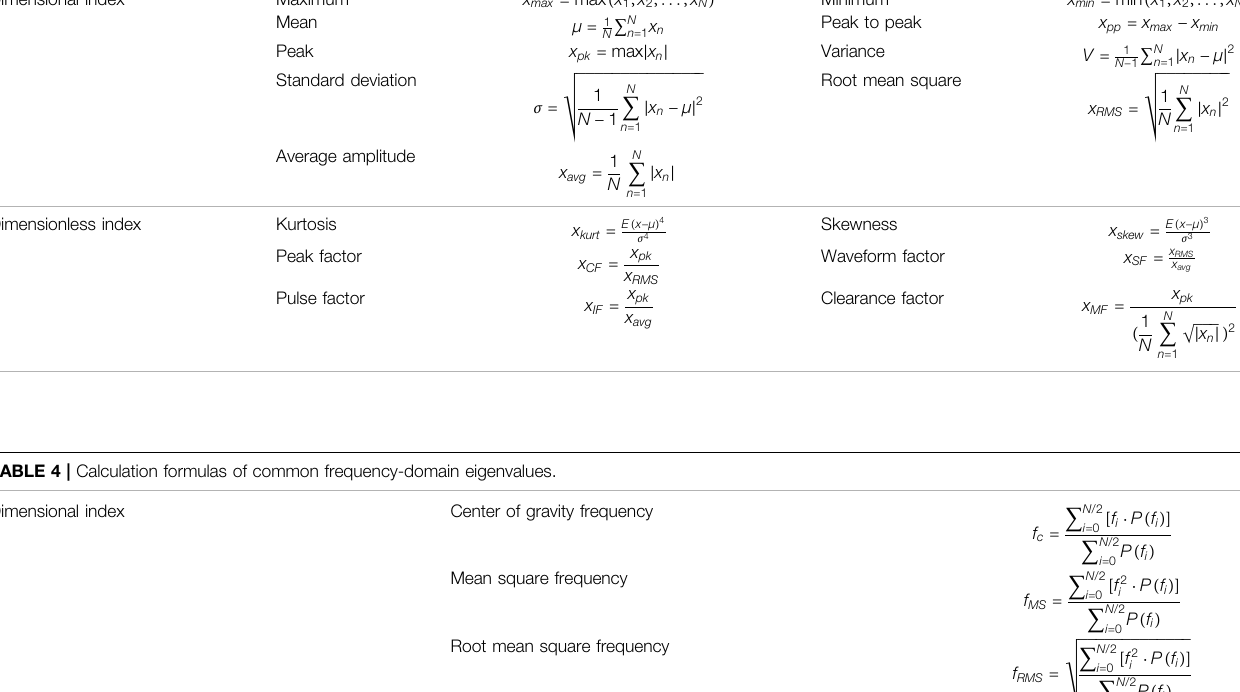
TABLE 3 | Calculation formulas of common time-domain eigenvalues. Dimensional